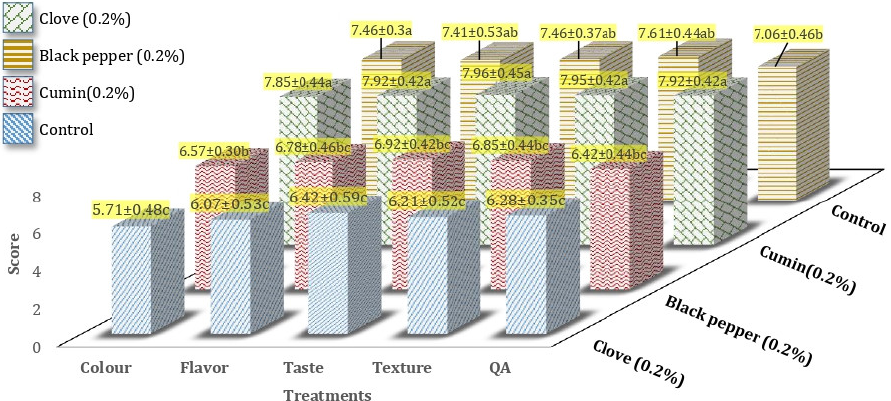
Figure 9. Mean values for a sensory score of processed Cheddar cheese made from buffalo milk after storage. a–c means followed by the same letter for the same parameter are not significantly different ( p <